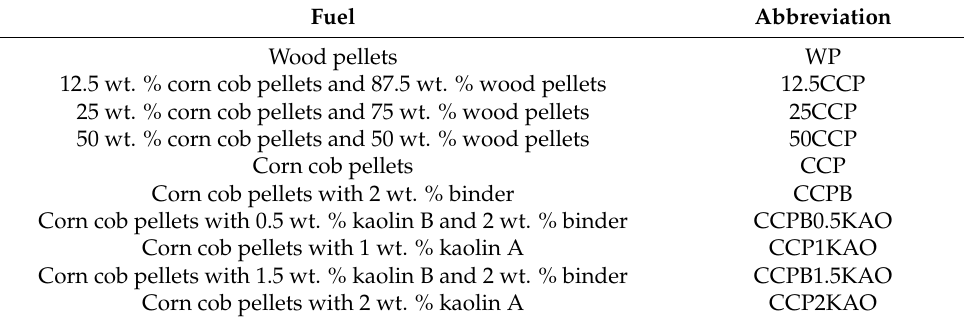
Table 2. Experimental